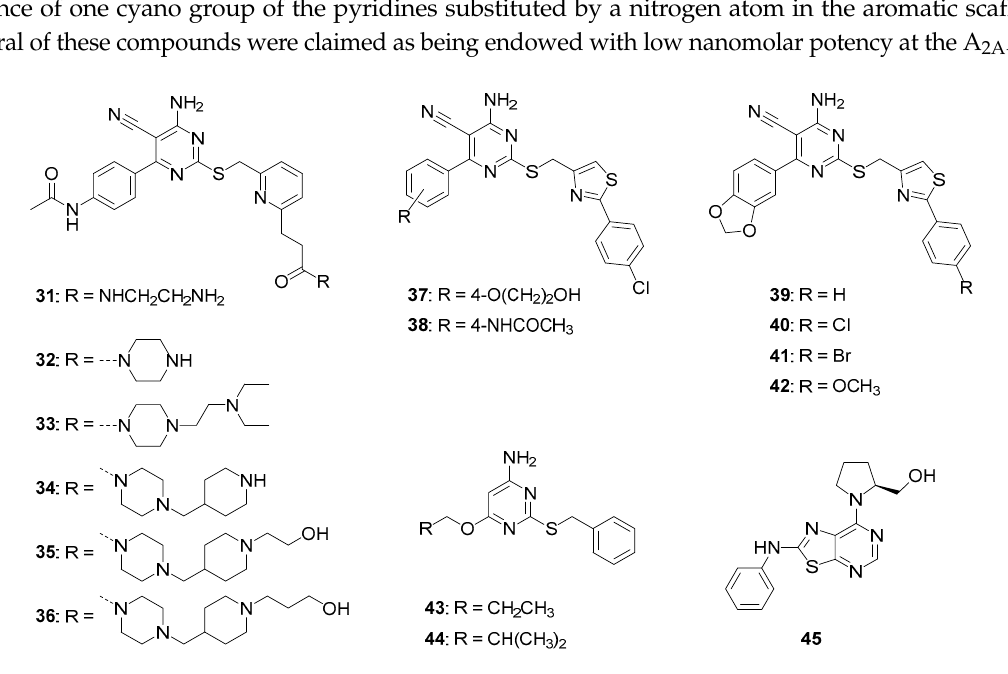
Figure 2. Selected pyrimidine-based non-nucleoside agonists of the adenosine receptors.